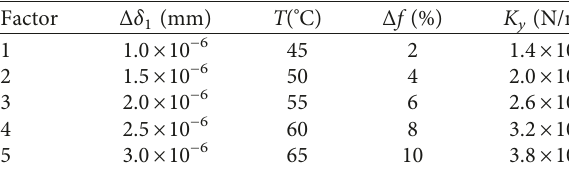
Table 1: Orthogonal factor levels.